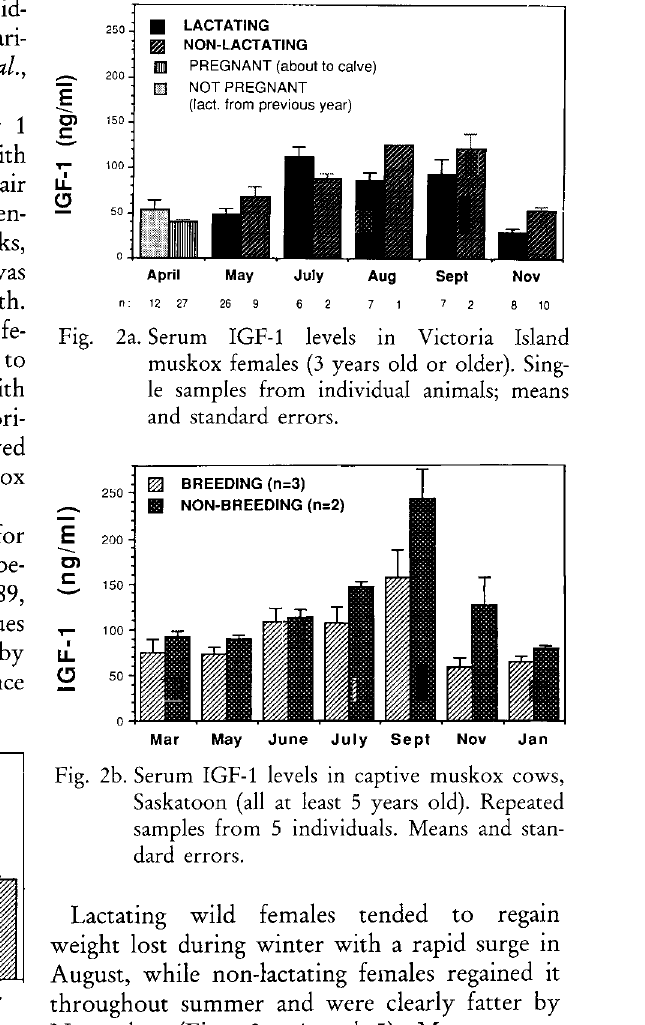
Fig. 2b. Serum IGF-1 levels in captive muskox cows, Saskatoon (all at least 5 years old). Repeated samples from 5 individuals. Means and stan dard